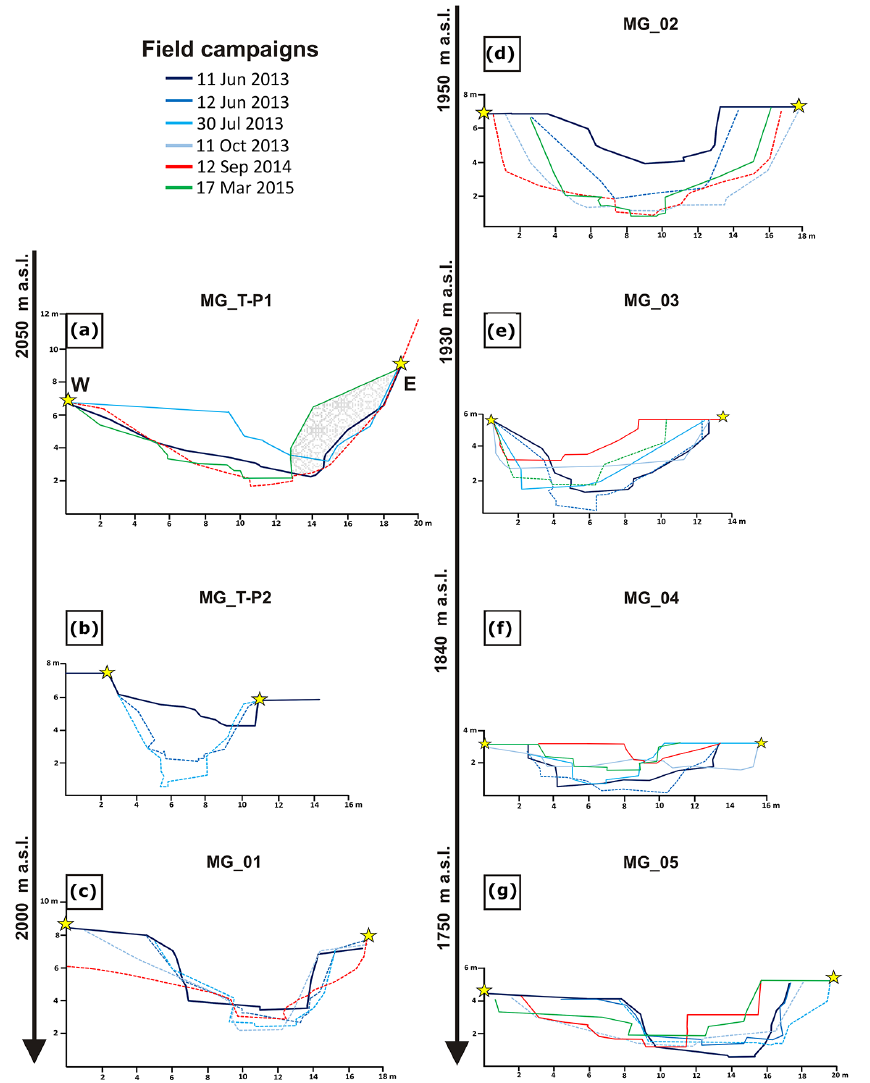
Figure 5. Comparative cross-section profiles of the checkpoints in Montegrande ravine, according to the field campaigns (Fig. 1 for location). (a) MG_T-P1, (b) MG_T-P2, (c) MG_01, (d) MG_02, (e) MG_03, (f) MG_04, and (g) MG_05. The dotted lines represent erosion, and lines represent deposition. The blue colors are related to the 2013 season, while the red and green lines refers to the 2014 and 2015 season